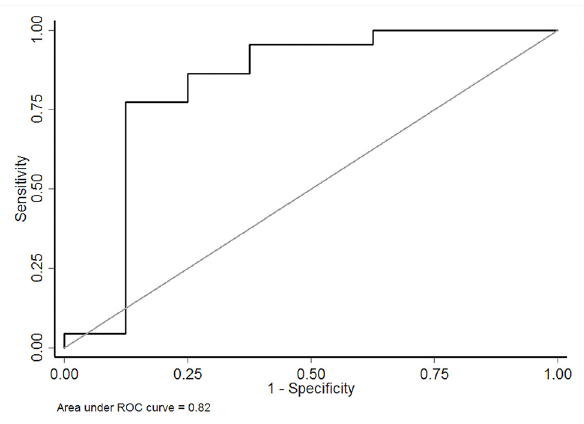
Fig 4. Receiver-operating characteristic curves of the combination of baseline arterial sRAGE, esRAGE, HMGB1, S100A12 and esRAGE in differentiating between the presence and absence of nonfocal loss-of-aeration in computed tomography scan morphology studies on day 0 in patients with acute respiratory distress syndrome.